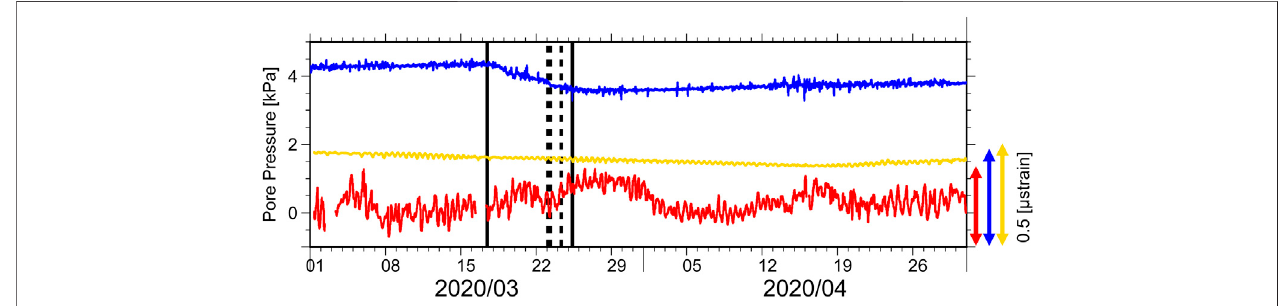
FIGURE 3 | Time history of the pore pressure at the deepest stations (Pc1) of each borehole observatory with a volumetric scale for each station (vertical double arrows). The oceanic signals are reduced by the reference hydraulic pressure gauge on the sea fl oor. The bold lines represent the onset/termination time of the pore pressure event. The dotted lines represent the origin times of the sVLFEs ( Table 1 ).